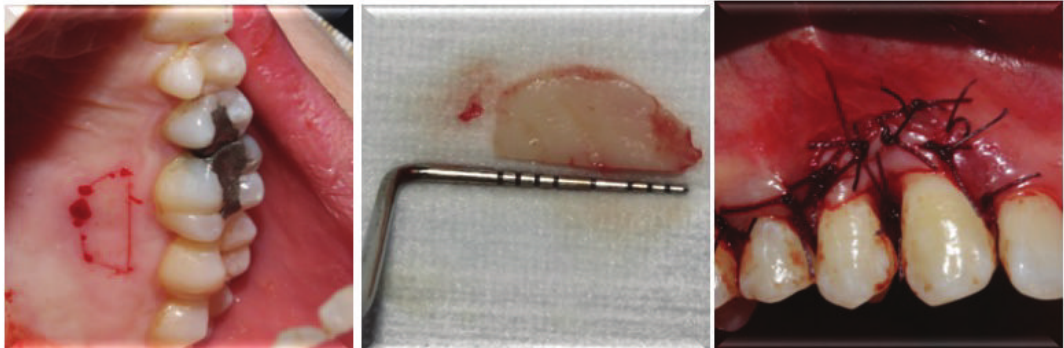
Figure 4: Reconstruction of surgical site with free gingival graft.